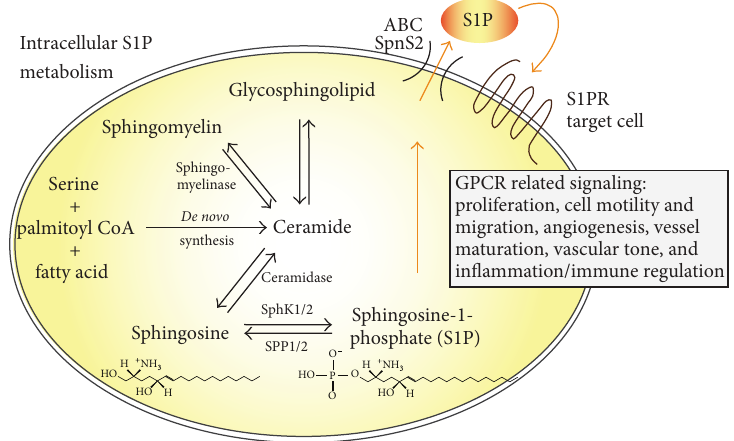
Figure 1: Synthesis of S1P and functions in the vascular system. De novo ceramide synthesis in general originates from condensation of serine, palmitoyl CoA, and fatty acid, a multistep enzyme catalysed process. Ceramide can be converted reversibly into sphingomyelin by sphingomyelinase or to glycosphingolipids. It is further metabolised by ceramidase to sphingosine, which can then be phosphorylated into S1P by sphingosine kinase isoforms 1 and 2 (SphK1/2). This phosphorylation can be reverted by the S1P phosphatases SPP1 and SPP2 or